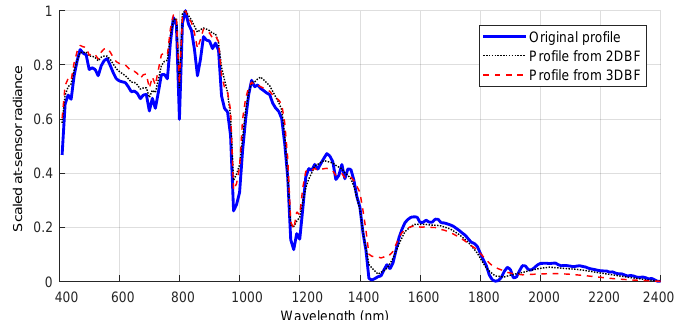
Figure 9. The spectral profiles of the pixel (18,6) from the original Indian Pines data, the 2DBF and the